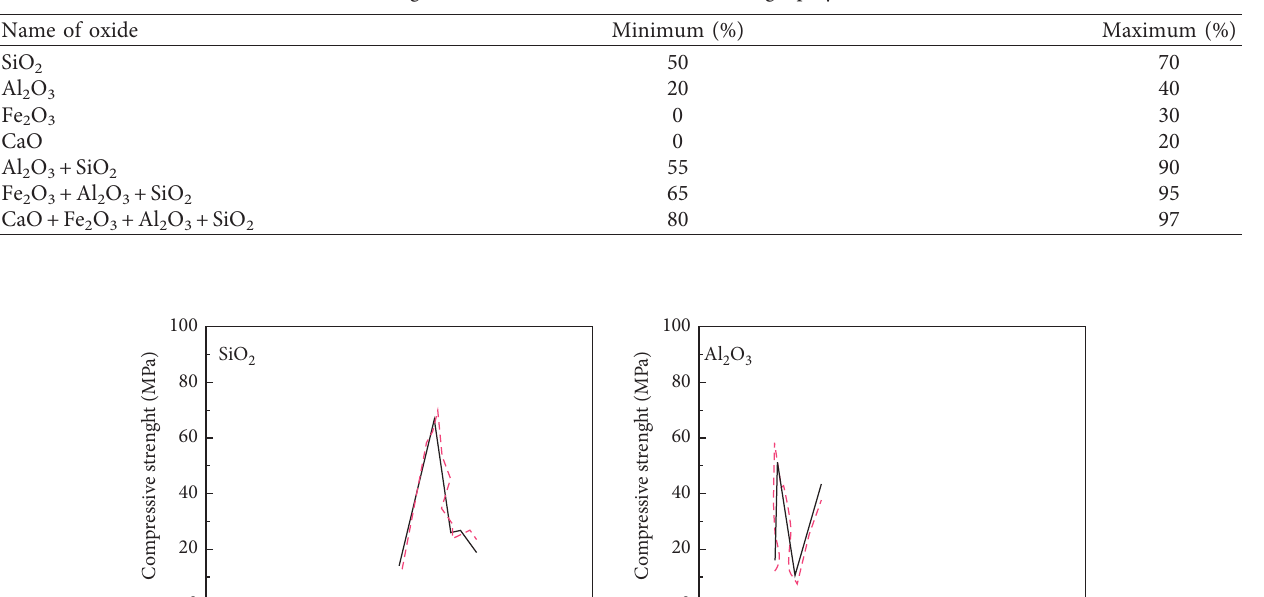
Table 11: Range of common oxide combination for geopolymer